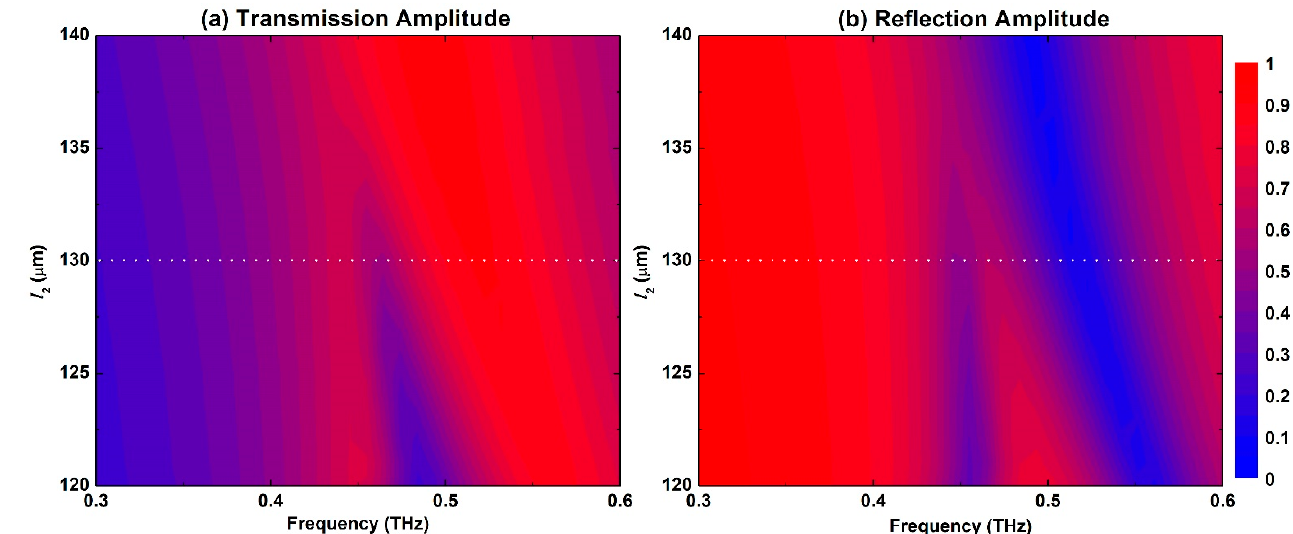
Figure 2. ( a ) Transmission and ( b ) reflection spectral map response of the S-shaped metasurface for l 2 values that swept between 120 μ m and 140 μ m with 1 μ m step.